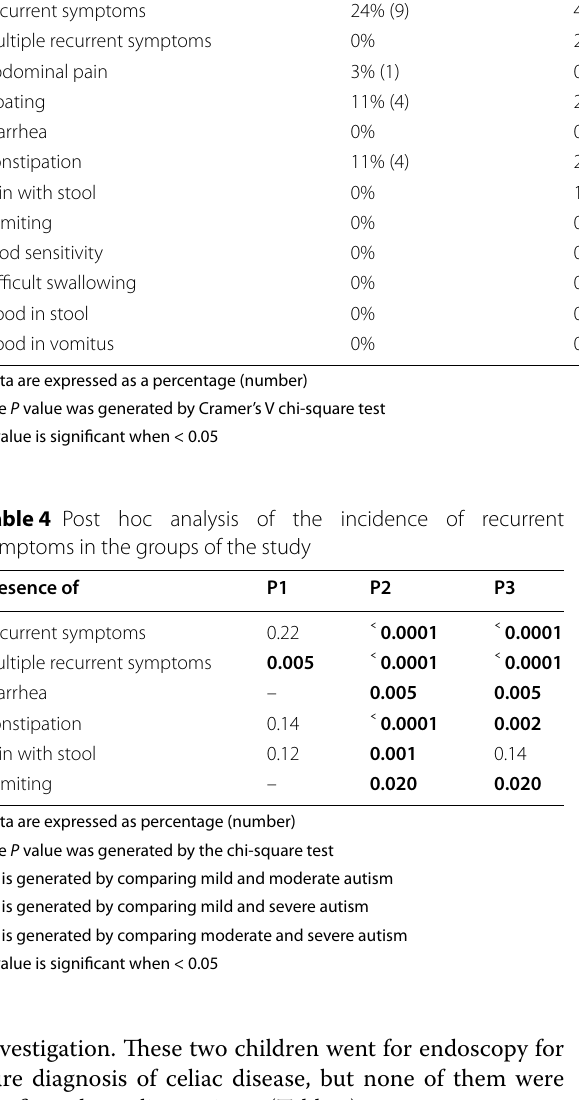
Table 3 Description and comparison of the recurrent symptoms among the three groups of the study